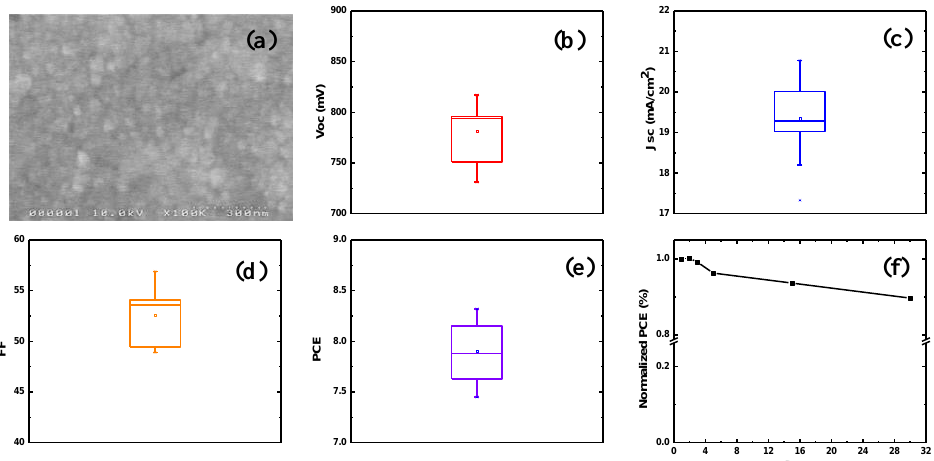
Figure 5. ( a ) Morphology of the CuI film (obtained from the iodization of 20 nm thin copper films at 10 °C) after transfer-printing on perovskite surface at 80 °C for 20 min at 4 bar pressure. ( b – e ) Whisker plots showing the statistical distribution of ( b ) V OC , ( c ) J SC , ( d ) FF and ( e ) PCE, based on 10 devices with transfer-printed CuI films, ( f ) Time–PCE curve for the champion device obtained with transfer-printed CuI HTL.